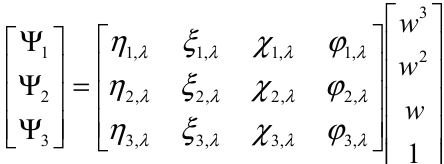
, Ψ , Ψ (unitless) from water vapor content ( w ) in 1 2 3